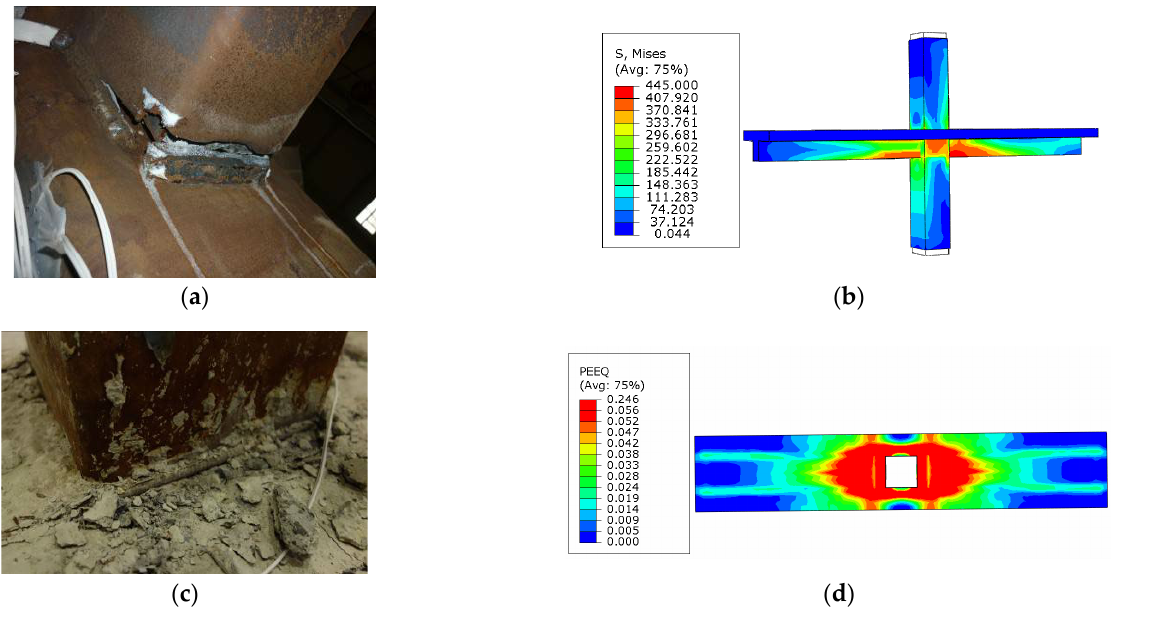
Figure 10. Comparison of tested and simulated failure modes of specimen C-1: ( a ) fracture of the bottom plate of U-shaped beam; ( b ) von Mises stress contour in the connection; ( c ) concrete crushing in the slab; ( d ) PEEQ contour in the concrete slab.